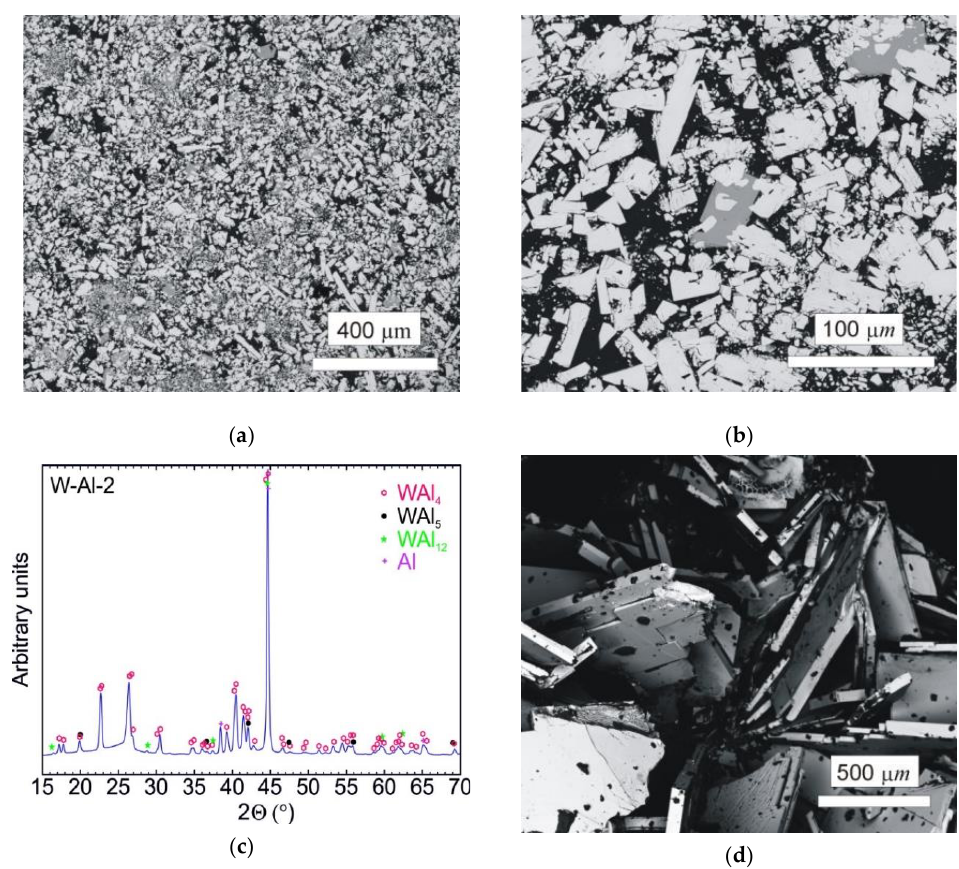
Figure 8. ( a ) SEM-BSE image of the bottom part of the W – Al-VIM-2 alloy; ( b ) SEM-BSE image of WAl 12 phase in the bottom part of the W-Al-VIM-2 alloy; ( c ) diffraction pattern of sample W – Al-VIM-2; ( d ) SEM-BSE image of the upper part of the W – Al-VIM-2 alloy.